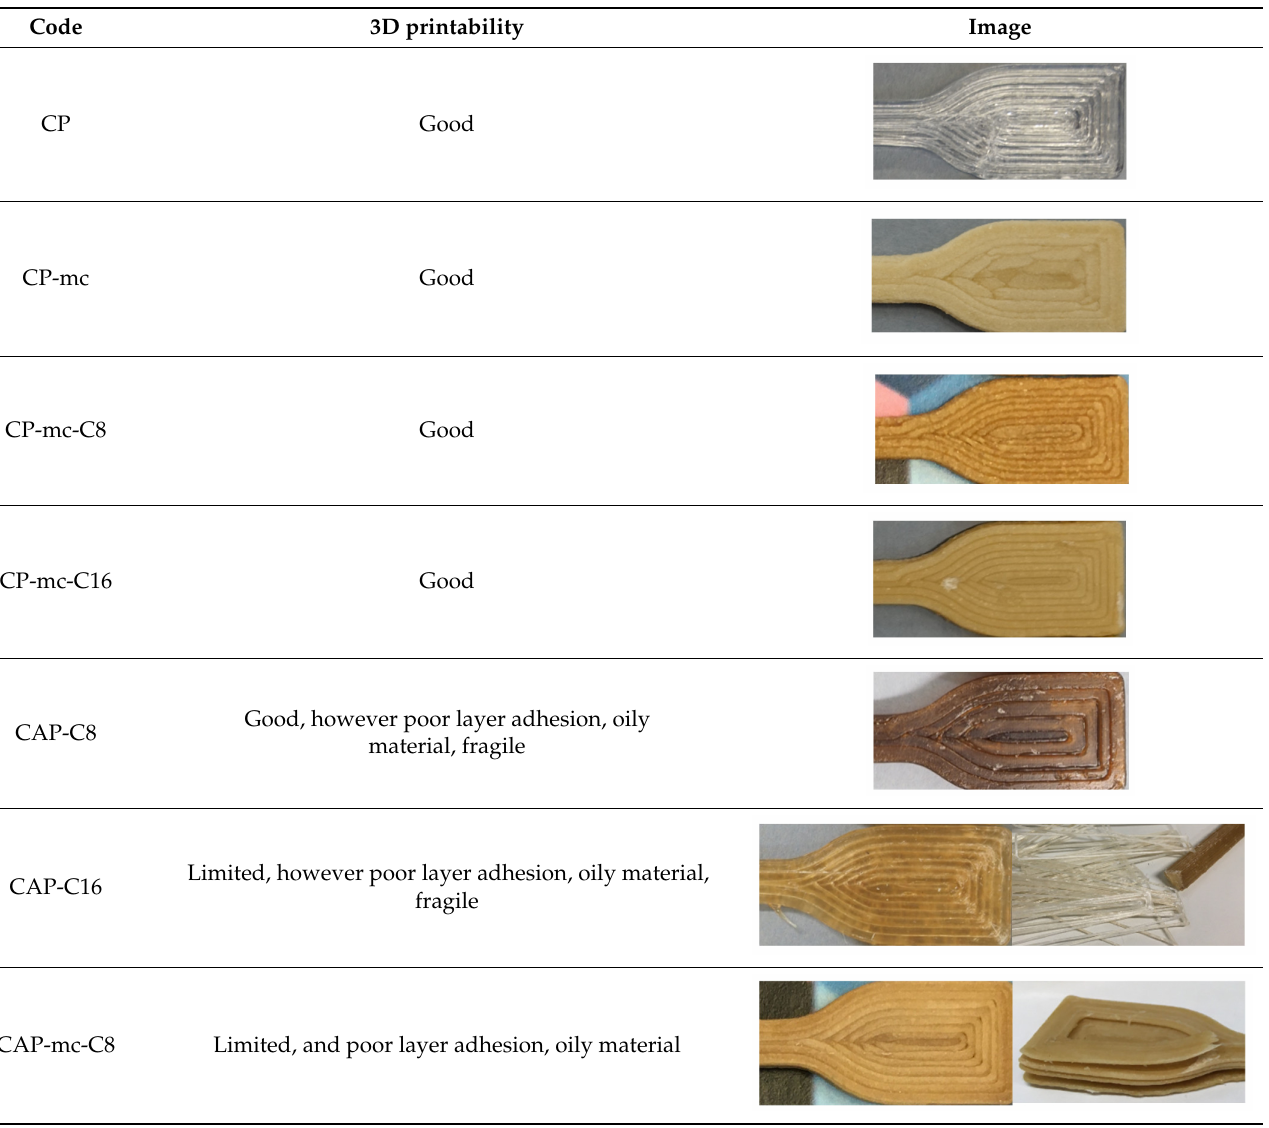
Figure 1. Granulate 3D printing head ( left ) and granules used in 3D printing process ( right ). Table 2. Results from 3D printing trials with granule printing